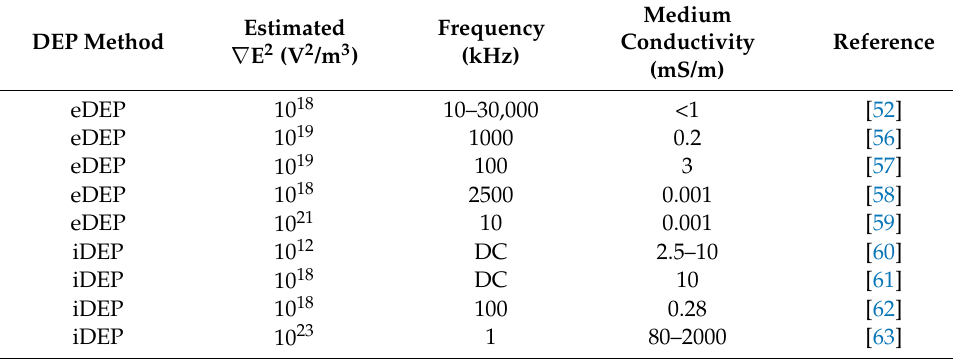
Table 1. Published parameters for DEP manipulation of BSA. ∇ E 2 estimated by Hayes